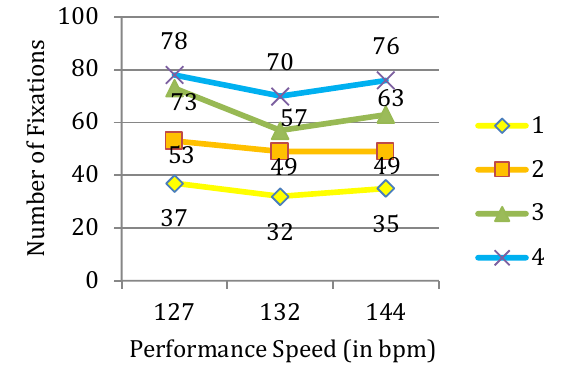
Figure 10. Comparison of the total number of fixations for the musical excerpt of ‘Porgy and Bess’ for 4 players across 3 performance speeds: 127, 132 and 144 beats per minute (bpm). Players are identified by their number (#1 to